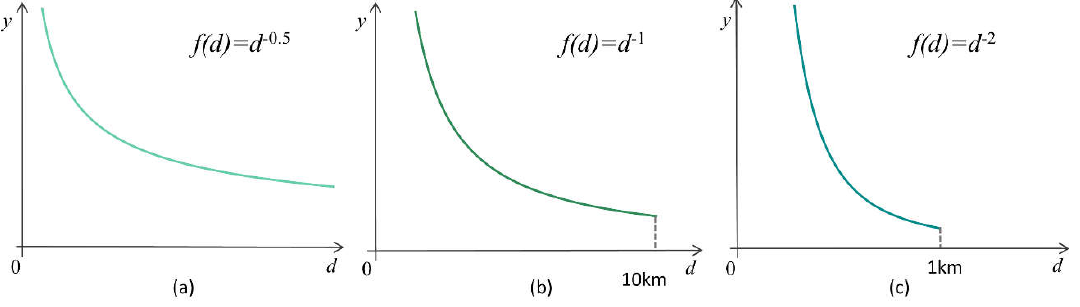
Figure 4. Schematic plot of distance attenuation functions for the three medical service levels in Shenzhen: ( a ) municipal hospital accessibility distance attenuation; ( b ) town‐level hospital accessibility distance attenuation; ( c ) community‐level hospital accessibility distance attenuation.